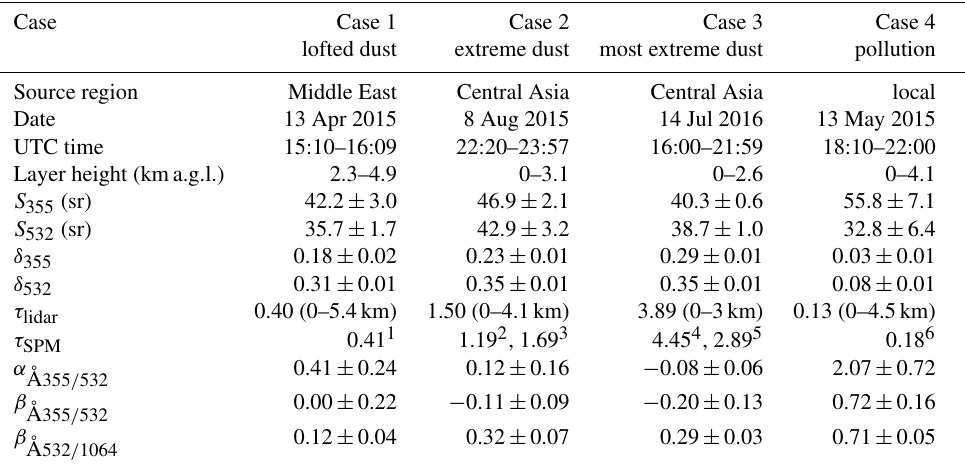
Table 3. Overview of the selected example cases. S 355 ,S 532 : lidar ratios at 355 and 532nm wavelength. δ 355 ,δ 532 : particle linear depo- larization ratios at 355 and 532nm wavelength. τ lidar : aerosol optical thickness measured with lidar at 532nm wavelength. τ SPM : aerosol optical thickness measurement of the co-located sun photometer at 500nm wavelength (time of measurements in the footnote). α extinction-related Ångström exponent based on the particle extinction coefficients at 355 and 532nm wavelength. β backscatter-related Ångström exponents based on the particle backscatter coefficients at 355, 532, and 1064nm wavelength. The height range to average the optical properties of the dust layers is placed within the core of each layer. The provided uncertainties are the standard deviations of the averaged